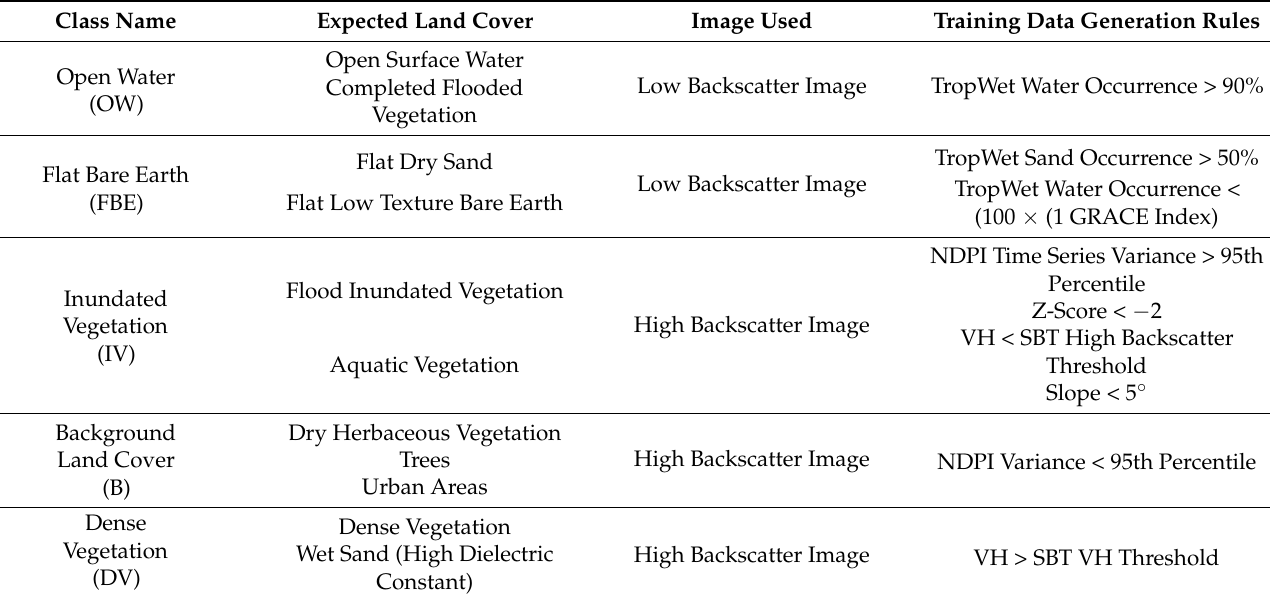
Table 2. Summary of thematic classes used in the Sentinel-1 image classification along with a detailed description of the rule base applied to generate classification training